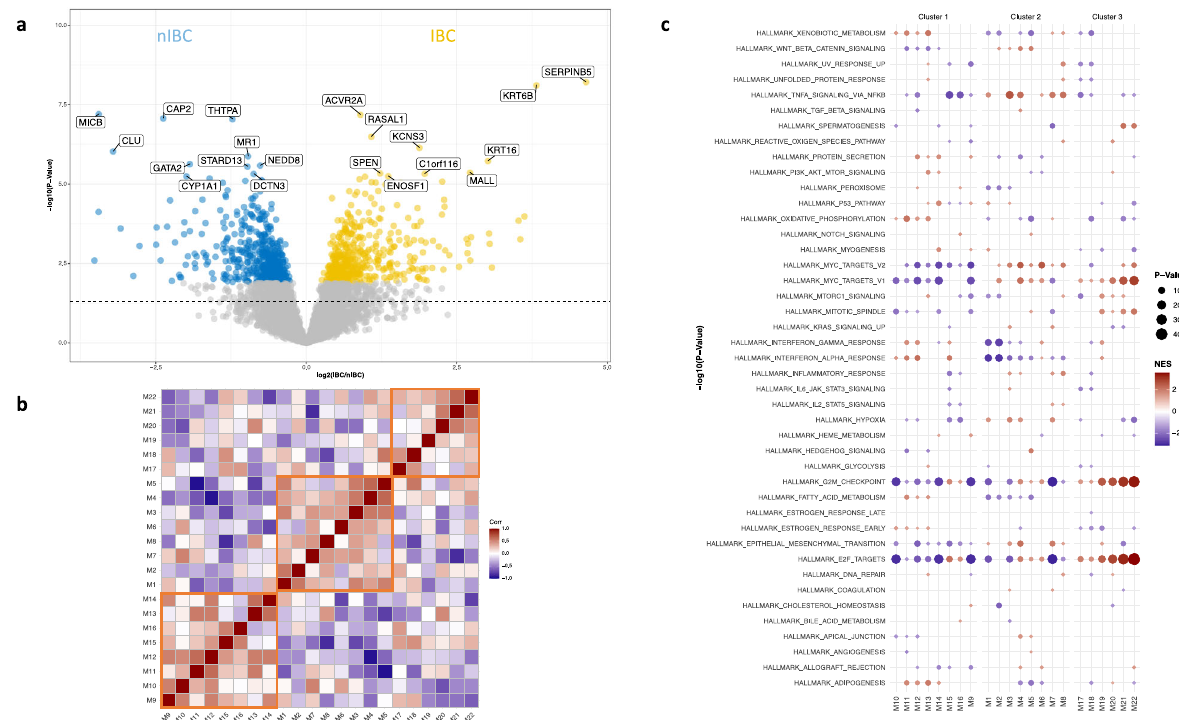
Fig. 2 Identi fi cation of molecular differences between IBC and nIBC preclinical models. a Volcano plot representing gene expression differences between IBC and nIBC preclinical models. The X-axis indicates the log2-transformed gene expression fold change in IBC relative to nIBC. The Y-axis represents the − log10-transformed p value. The horizontal dashed line represents a nominal P value threshold of 5%. Genes color-coded yellow and blue are overexpressed in IBC and nIBC respectively at a false discovery adjusted p value of 10%. The top 10 overexpressed genes in IBC and nIBC cell lines are labeled. b Heatmap representing the correlation structure of 22 co-expression modules identi fi ed using WGCNA. Pearson correlation coef fi cients resulting from pairwise comparisons of the eigengenes of the different co- expression modules are coded according to a blue-red color scheme re fl ecting correlation coef fi cients ranging from − 1 to 1. Row and columns are labeled with the names of the co-expression modules and are ordered according to an unsupervised hierarchical cluster analysis. The three co-expression cluster groups are indicated in orange squares. c Dot plot representing the result of a gene set enrichment analysis (GSEA) obtained by comparing the gene-module membership scores for each co-expression cluster to the hallmark gene sets. The co- expression modules are listed along the X-axis and a different facet is created for each co-expression cluster. Enriched hallmarks per modules are indicated using a dot, the color and size of which vary with respectively the normalized enrichment score (i.e., blue = low; red = high) and the − log10-transformed p value (i.e., small = less signi fi cant; large = more signi fi cant) that result from the